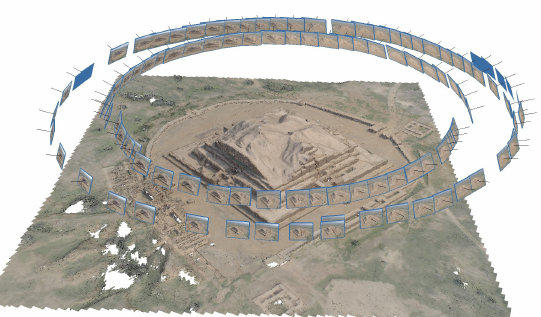
Figure 6. - Planimetric positions of GNSS GCPs.